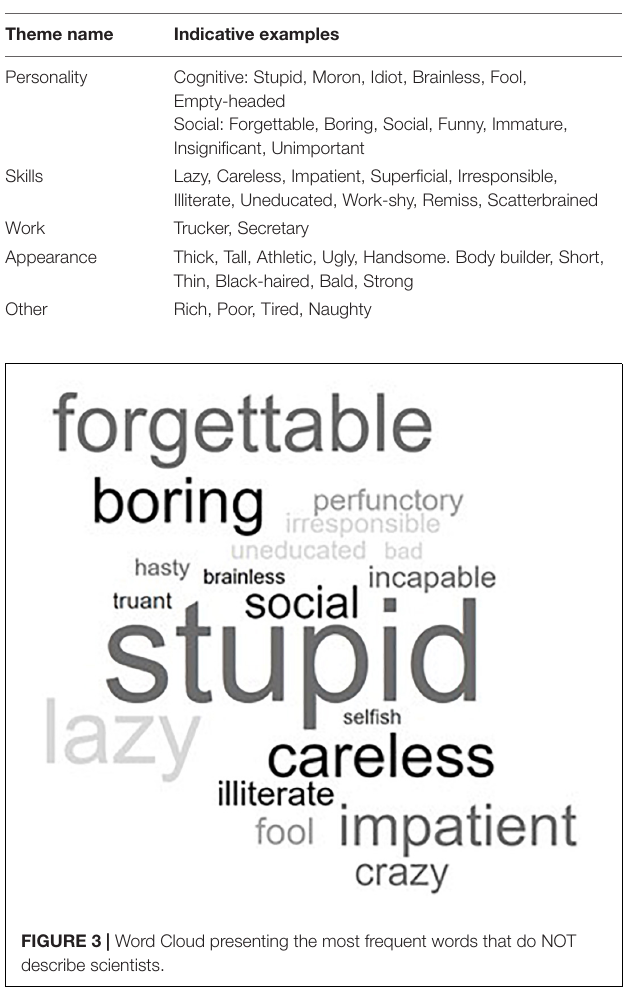
Fujiwara et al., 2022), and in that sense, it is possible to have influenced Students’